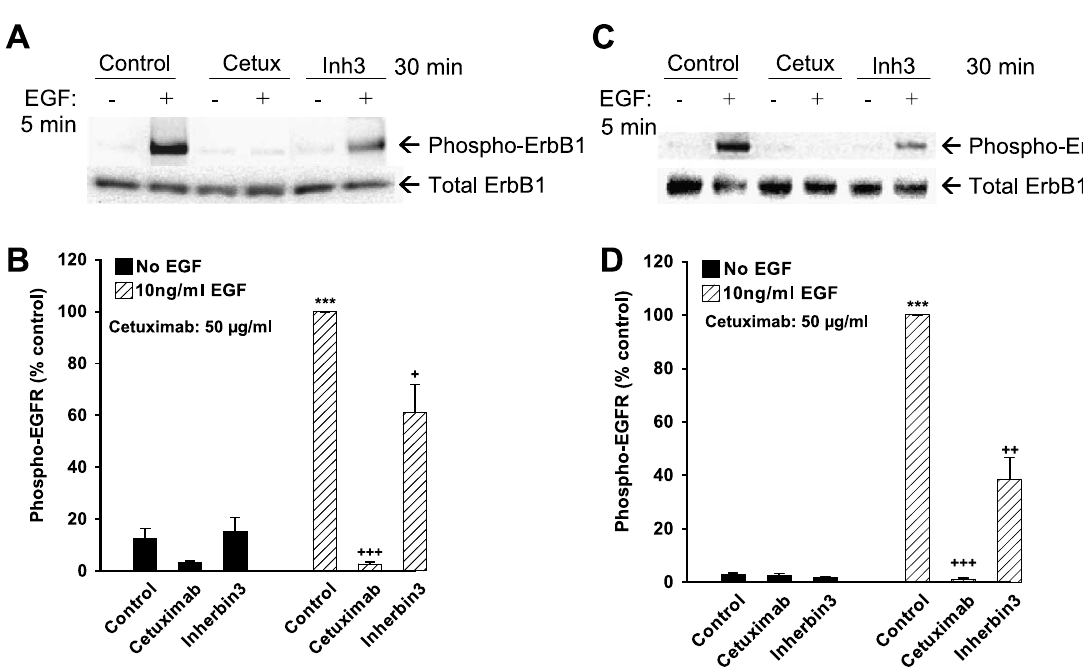
Fig. 4. Effect of Inherbin3 on ErbB1 phosphorylation. HN5 cells (A and B) or A549 cells (C and D) were treated with 23 µM Inherbin3 and 50 µg/ml Cetuximab for 30 min followed by stimulation with 10 ng/ml EGF for 5 min. For HN5 cells, immunoblotting was performed using phosphorylated ErbB1, followed by membrane stripping and reprobing against total ErbB1 and actin. For A549 cells, cell lysates were subjected to immunopurification using phospho-tyrosine antibodies followed by SDS-PAGE and blotting against total ErbB1. (A and C) Representative blots from one experiment. (B and D) Densitometric quantifications of phospho-ErbB1 immunoblots (B) or total ErbB1 blots of phosphoty- rosine-purified lysates (D) from five to six independent experiments. The level of ErbB1 phosphorylation is expressed as mean ± SEM of band intensity in phospho-ErbB1 blots (B) or total ErbB1 blots of phosphotyrosine-purified lysates (D). The level of ErbB1 phosphorylation in EGF-treated cells not treated with peptide was set as 100%. ∗∗∗ p < 0 . 001, significant difference compared with untreated control cells (no pep- tide, no EGF) (Student’s paired t -test). + p < 0 . 05, ++ p < 0 . 001, significant difference compared with EGF-treated control cells (no peptide, EGF) (Student’s paired t